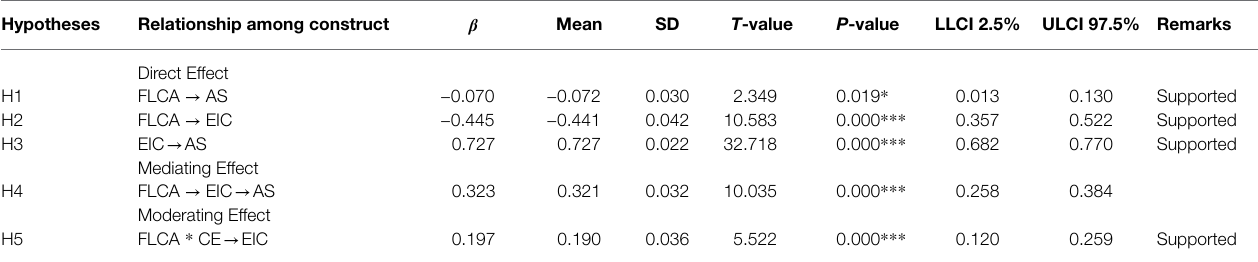
TABLE 4 | Mediation and moderation